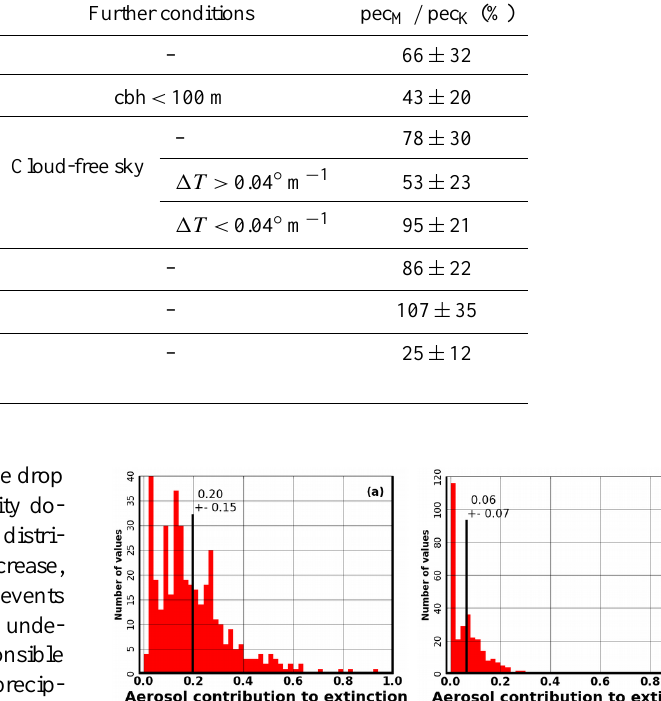
Table 4. Values of the average ratio pec M / pec K for different events; cbh is cloud base height, and (cid:49)T is the vertical thermal gradient. Event